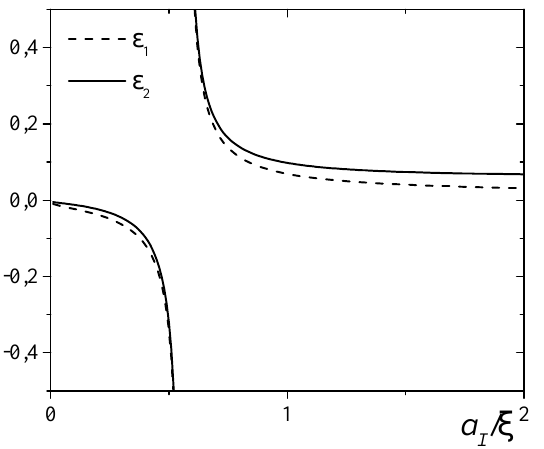
(cid:16) (cid:17) a I ; ∞ (see Equation (23)) in 2D case. ξ